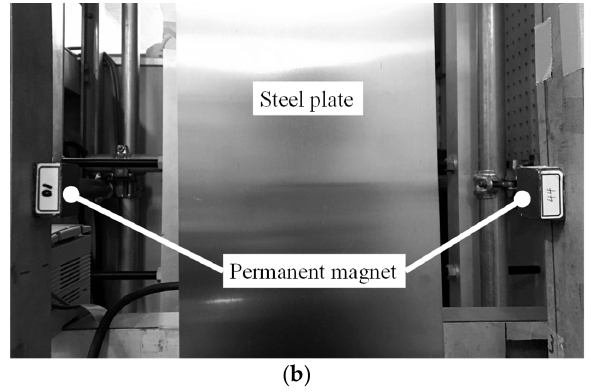
Figure 3. Permanent magnets placed near both the edges of the steel plate. ( a ) Schematic drawing; ( b ) Photograph of arrangement.